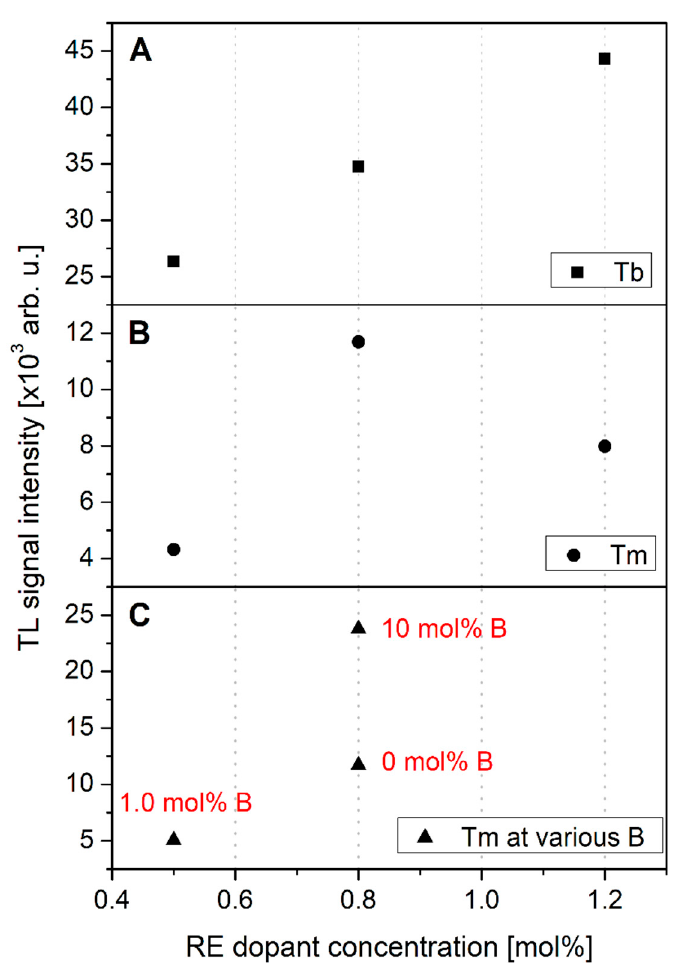
Figure 7. Thermoluminescence signal intensity as the function of the concentration of the RE doping ions: Tb (panel A ), Tm (panel B ), Tm at the presence of additional B co-doping ions (panel C ). Note that in most cases the error bars are smaller than the size of measured data-points.